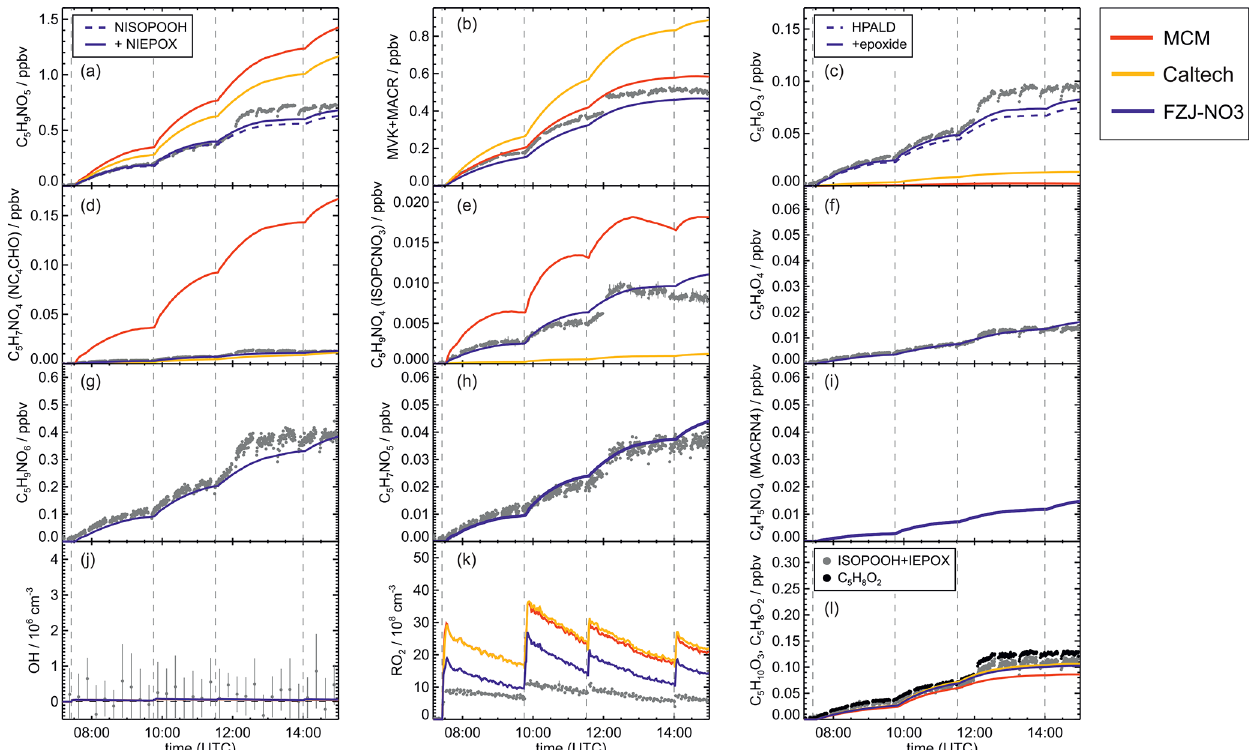
Figure 4. Comparison of results from model calculations applying the different isoprene NO 3 chemistry mechanisms for the experiment on 9 August 2018 (Experiment 1), when HO 2 concentrations were enhanced and excess CO was present as an OH scavenger. MVK, MACR, NISOPOOH, ISOPCNO 3 and NC 4 CHO are produced from all mechanisms, whereas the other species are only produced from either 1,6- H-shift reactions or ring-closure reactions of nitrate alkoxy radicals implemented only in the FZJ-NO3 mechanism. Grey and black dots are measured values. Measured organic peroxy radical concentrations only include part of the total RO 2 because the LIF instrument cannot detect a fraction of nitrate RO 2 (Vereecken et al., 2021). Organic products were detected by the Vocus PTR-MS instrument, which was only calibrated for MVK and MACR. All other traces are scaled to match best the results from the FZJ-NO3